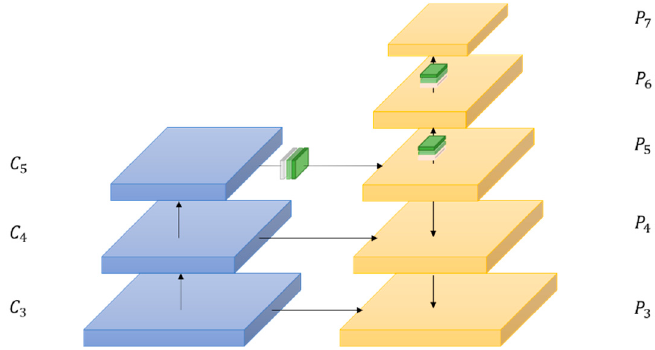
Figure 7. The multi-scale feature extraction network with FE-block module added.